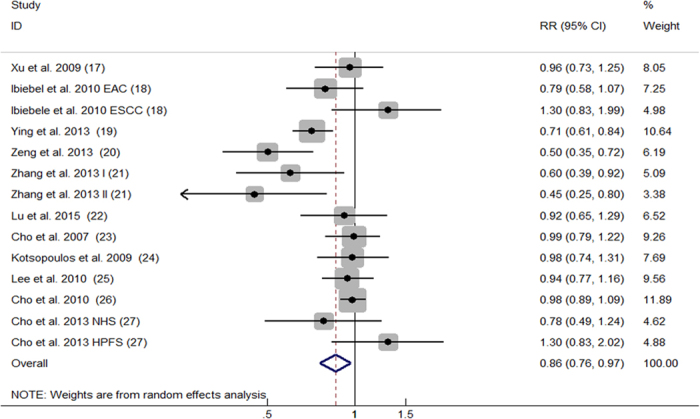
Forest plot of highest versus lowest categories of betaine consumption on cancer risk.RR, relative risk; CI, confidence interval; EAC, esophageal adenocarcinoma; ESCC, esophageal squamous cell carcinoma; I, stage one; II stage two; HPFS, The Health Professionals Follow-up Study; NHS, The Nurses’ Health Study.